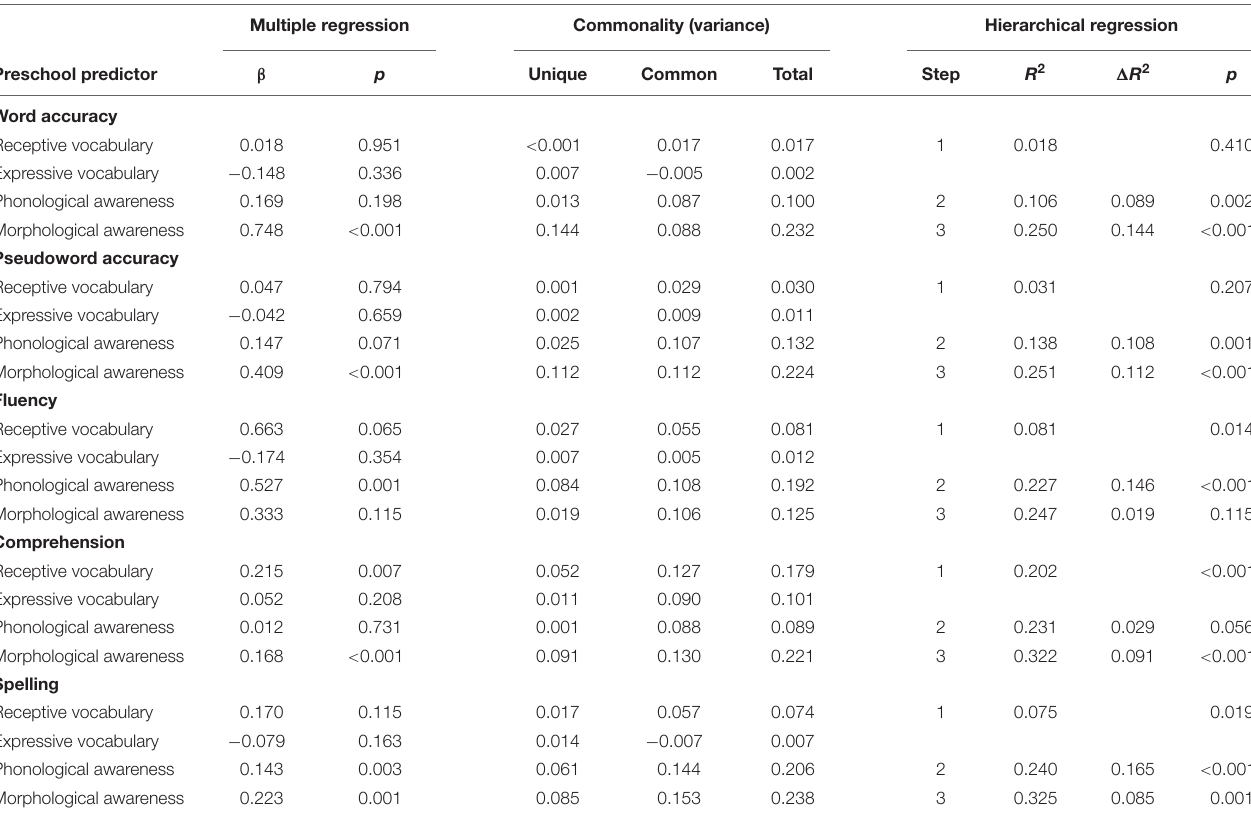
TABLE 3 | Results of regression analyses for the longitudinal prediction of Grade 1 reading skills. Multiple